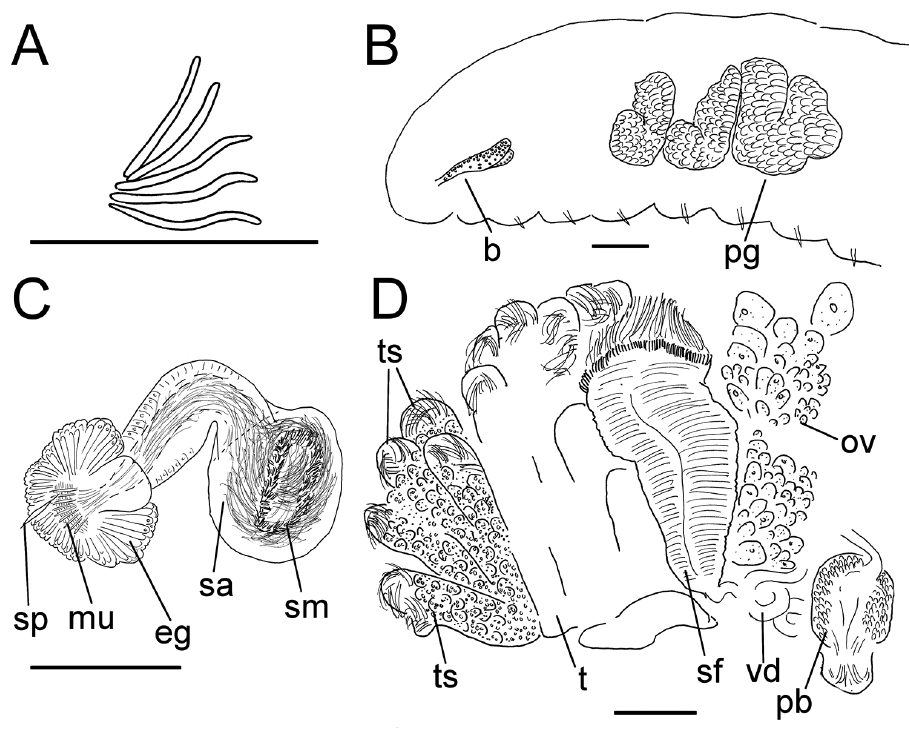
Figure 2. Lumbricillus lineatus . A Chaetal bundle B Anterior body C Spermatheca (neotype) D Other genitalia. Abbreviations under general notes. Scale bars: 100